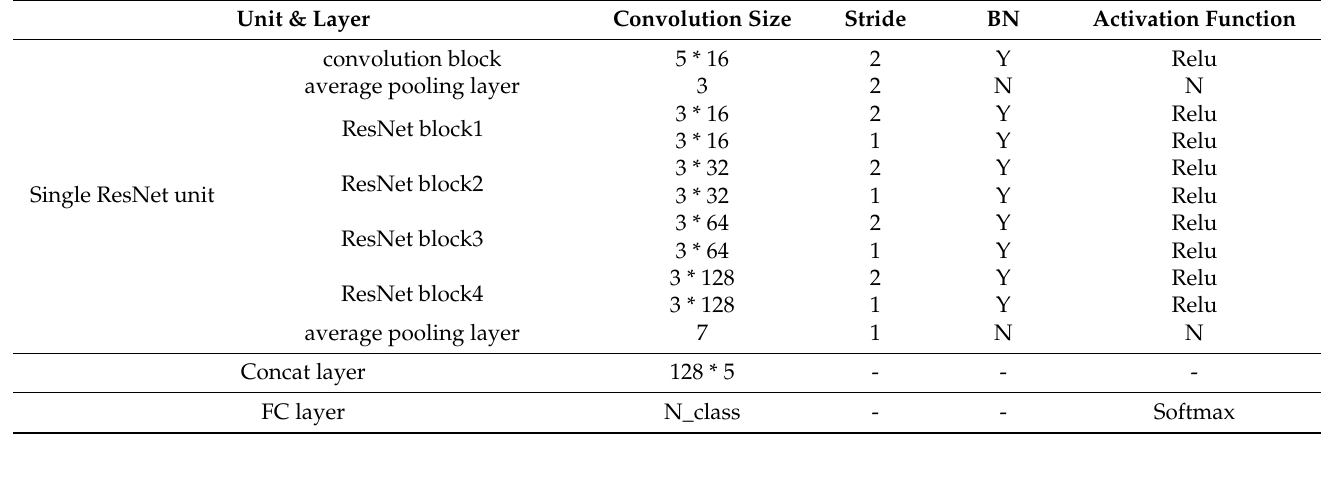
Table 4. Details of the multi-input ResNet.